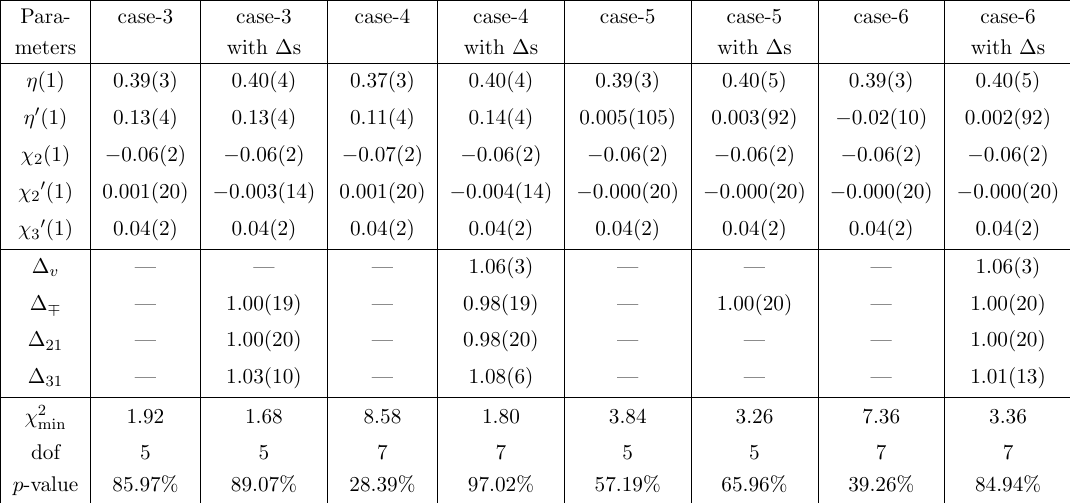
Table 15 . The (cid:12)t results for the subleading Isgur-Wise parameters with (cid:31) 2 (1), (cid:31) 0 varied within their QCDSR 1 (cid:27)